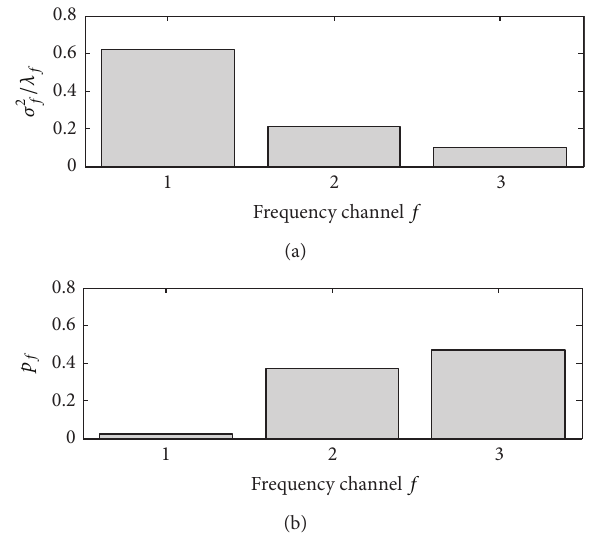
Figure 3: The conditions and transmitted energy allocation of frequency channels.